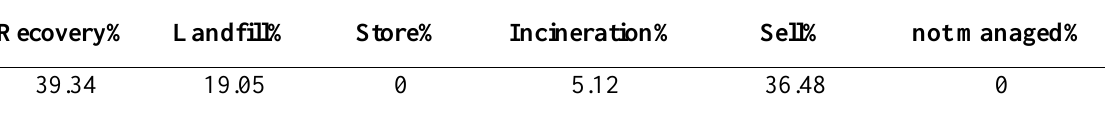
Table 3: anticipated results of APC solid waste management in the future